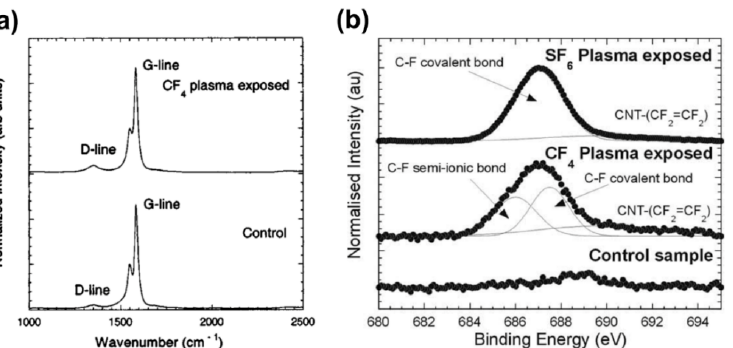
Figure 7. ( a ) Raman spectra of control and CF 4 plasma exposed single-walled CNTs. ( b ) The deconvoluted F 1s peak for the SF 6 and CF 4 plasma exposed SWCNTs at − 200 V for 1 min in comparison to the unexposed control sample. Reprinted with permission from Ref. [49]. Copyright 2004 Elsevier.